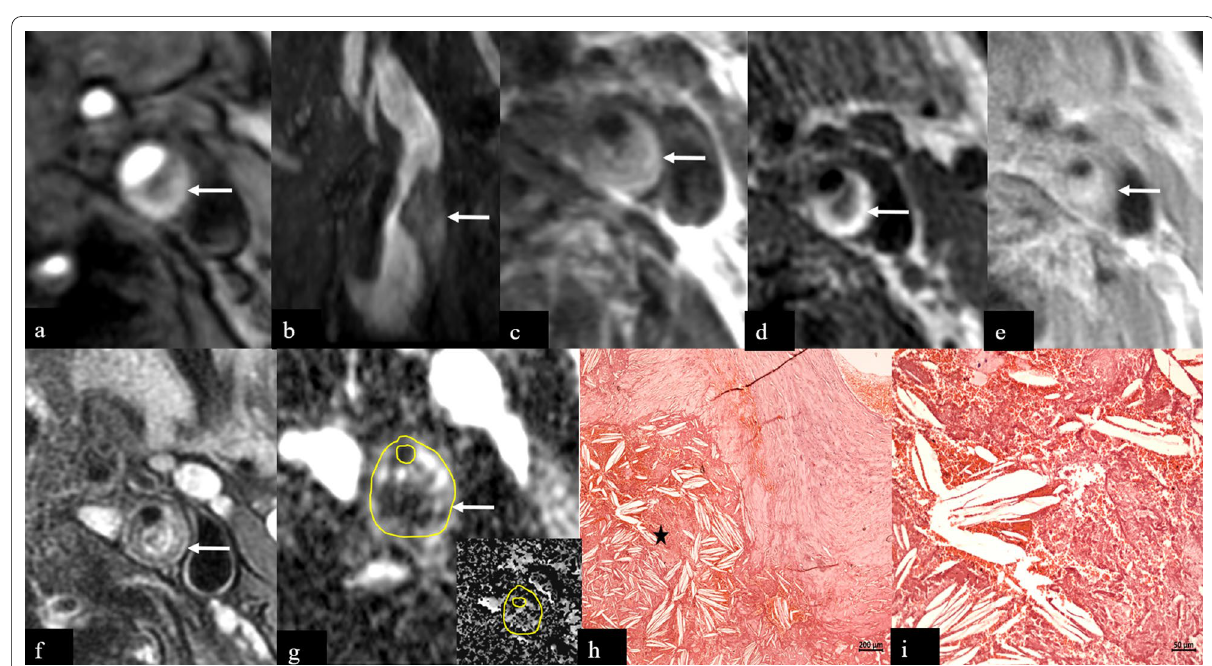
Fig. 1 Carotid MR images of an ICA plaque in a 70-year-old diabetic male who had symptomatic left MCA stroke, who had NIHS score of 8 at admission, and no prior cerebrovascular events were detected to have 72% stenosis in MR TOF ( a , b ), with the ICA plaque (arrows) showing TOF(A) and T1 ( c ) hyperintensity indicative of intraplaque hemorrhage. The plaque appeared predominantly hyperintense in T2 ( d ), PD ( e ), and T2FS ( f ). DWI image ( g ) showing plaque with inset showing ADC map with margins of vessel wall and vessel lumen demarcated by line tracing adapted from corresponding T2FS image. The plaque had average ADC value of 0.83 10 –3 mm 2 /s. Histopathological images ( h , i ) of the same plaque showing × intraplaque hemorrhage (*) containing RBCs admixed with few cholesterol clefts. (Hematoxylin and eosin, h original magnification